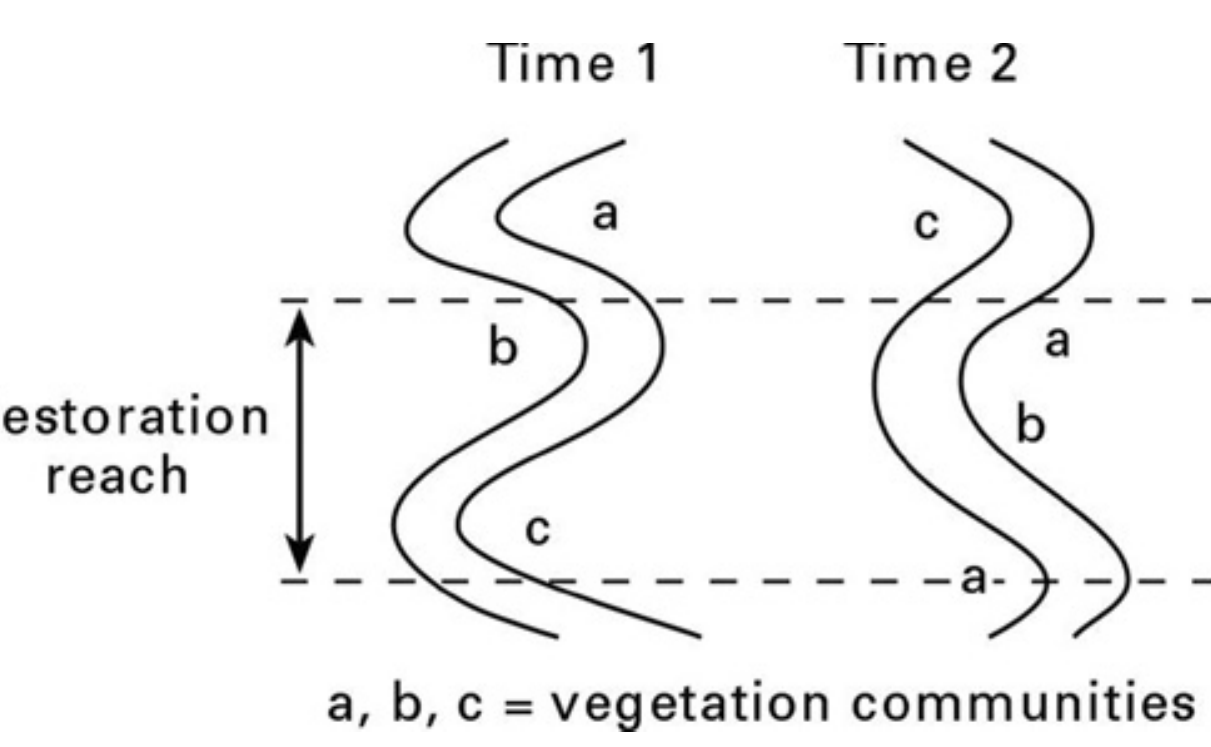
Fig. 2. At a small spatial scale (reach scale of 10 2 m), considerable changes in vegetation communities can be observed between two time periods in a geomorphologically active